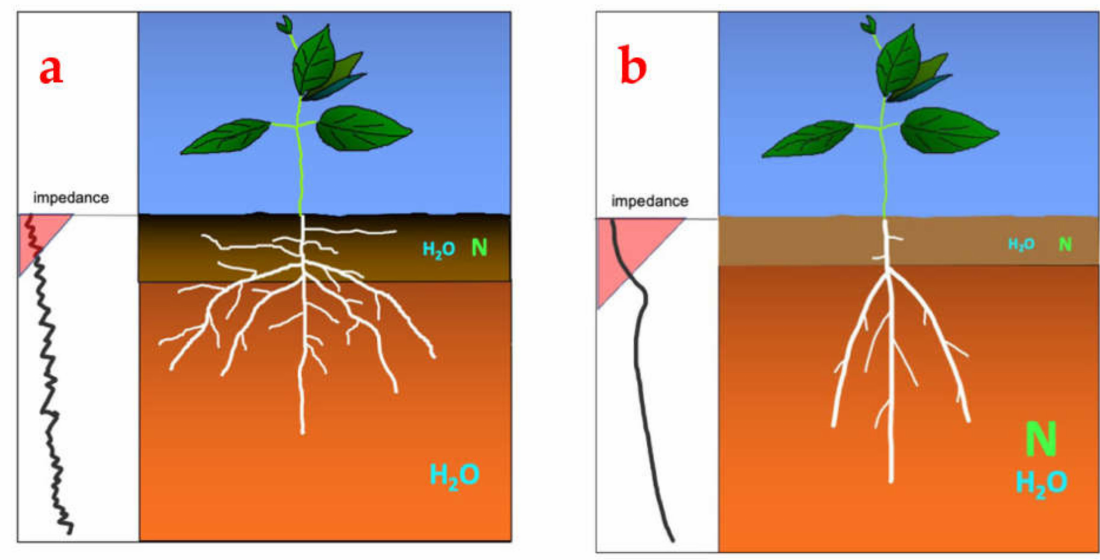
Figure 2. Root profile and behavioral response to impedance and nitrates dynamics in tillage ( a ) native soils, due to drought-induced hardened topsoil and ( b ) tilled soils in mechanized conventional tillage with less low-resistance pathways and deeper nitrogen availability due to nitrate leaching